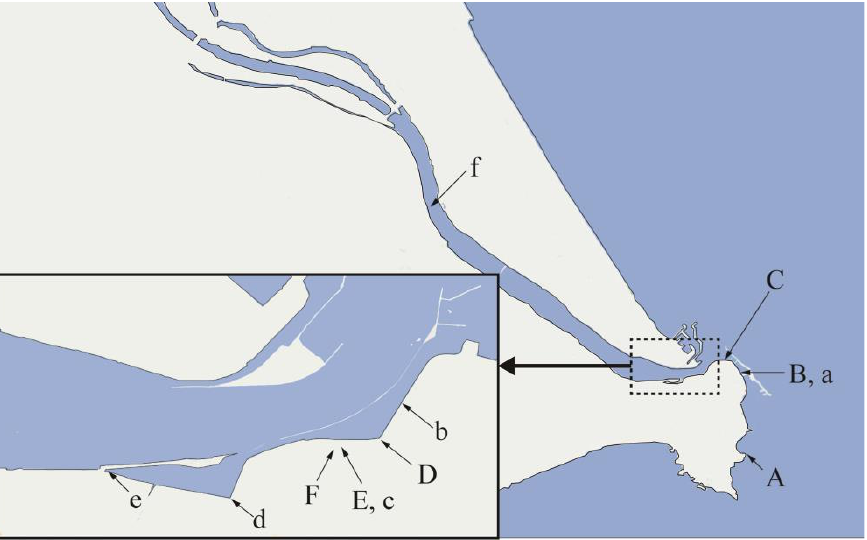
Figure 1. Sampling points. Sampling at the points shown in uppercase and lowercase letters was performed on different days. Points “B” and “a” and points “E” and “c” represent the same sampling points.